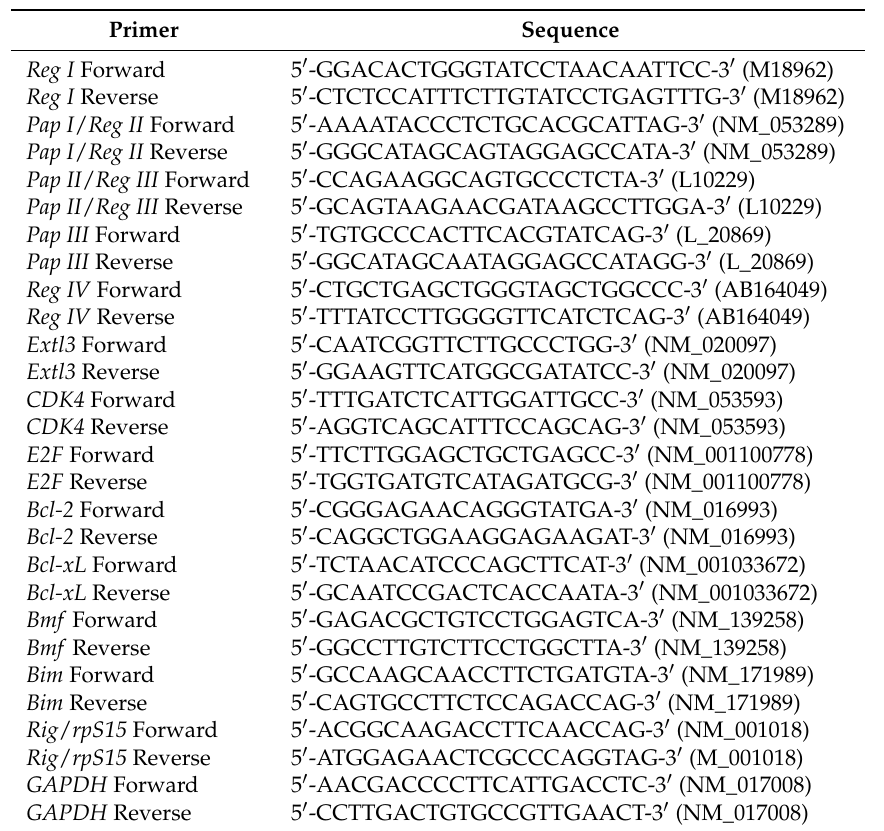
Table 1. Primers used for real-time RT-PCR of rat